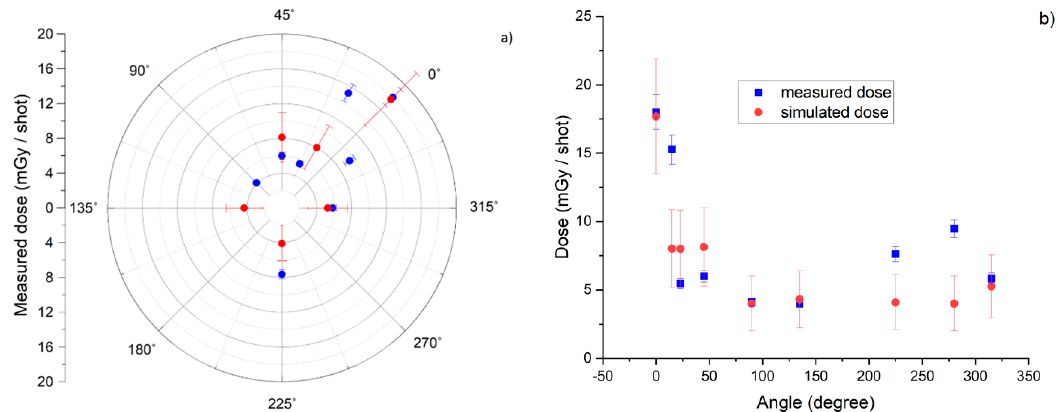
( a ) Map of the measured dose (blue dots) inside the target chamber and of the simulated radiation dose (red dots); ( b ) The fluctuations in the angular distribution of measured and simulated